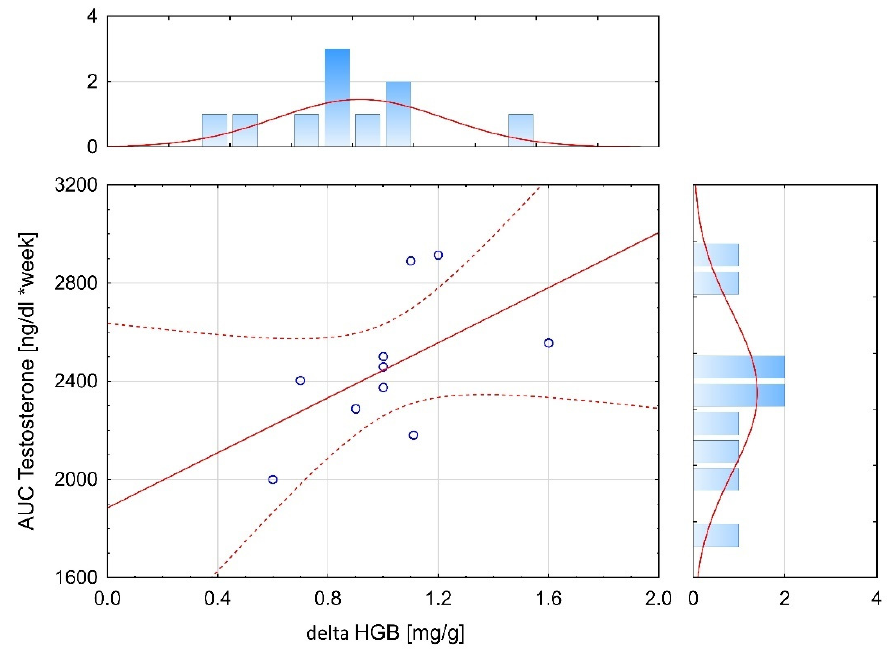
Figure 5. Correlation between area under the curve (AUC) for testosterone levels over 4 weeks (AUC testosterone) and delta values of hemoglobin concentration ( ∆ HGB) during the experiment in the LH–TL group.